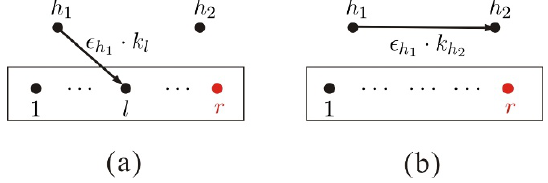
Figure 23 . The graph (a) is the skeleton F 0 for the gauge invariance induced identity (3.1) with H = f h 1 g . The graph (b) for l 2 f 1 ; : : : ; r (cid:0) 1 g is a typical graph F containing the skeleton (a).